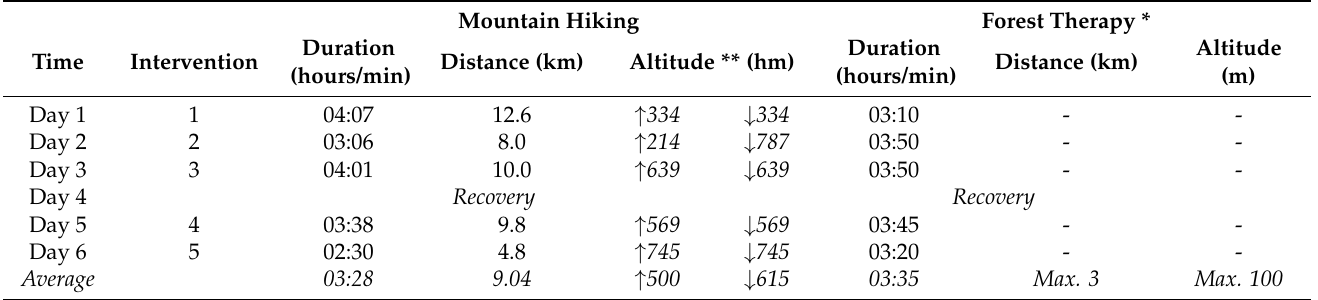
Table 2. Characteristics of the intervention